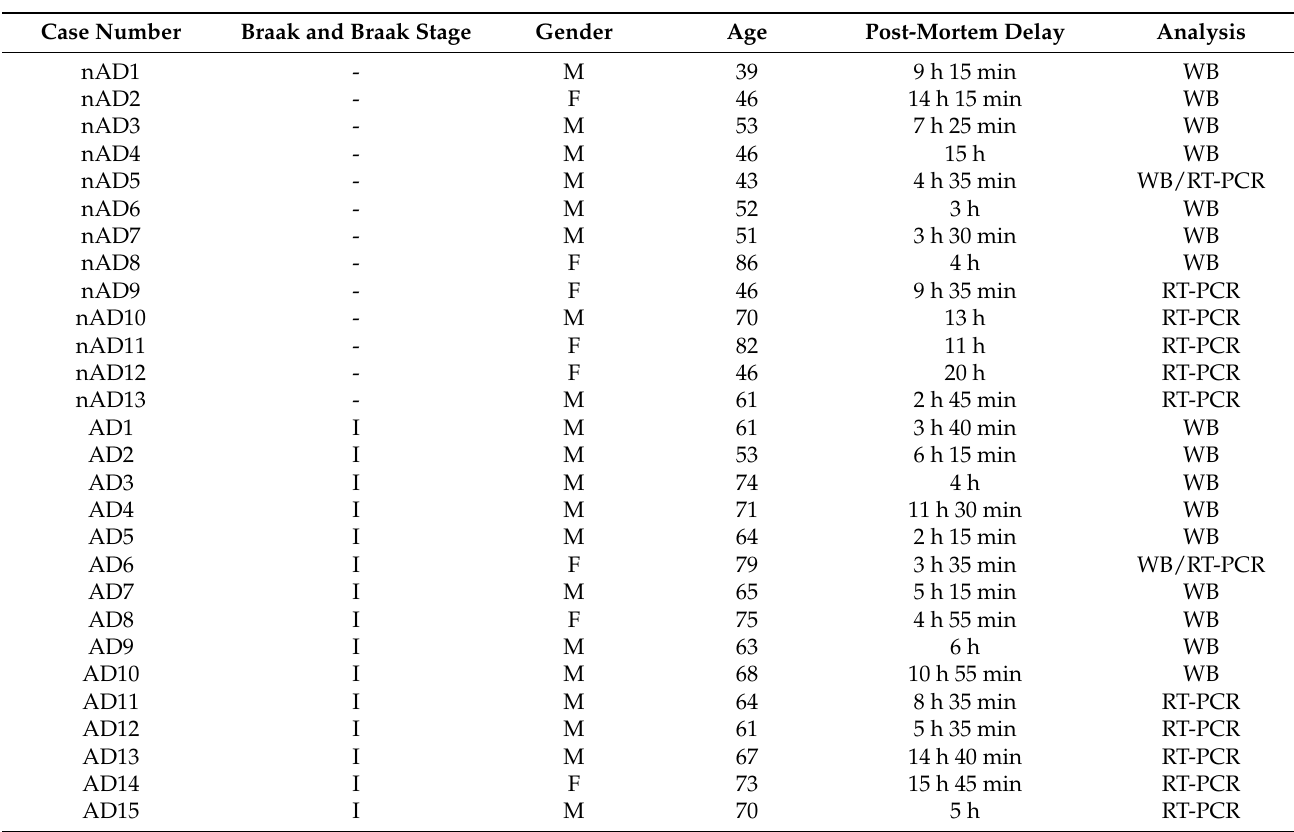
Table 1. Control (nAD) and AD samples, categorized as stages I to VI of Braak and Braak, used in this study. Case Number Braak and Braak